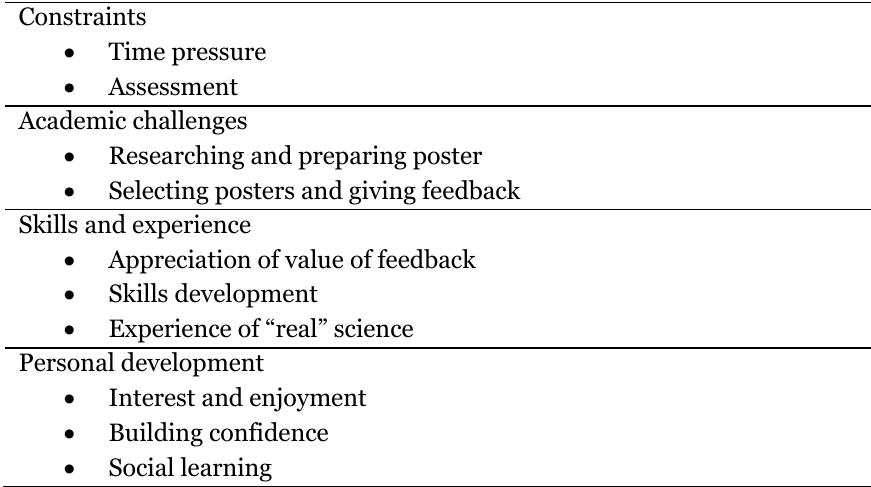
Themes and Subthemes Identified from Focus Group Discussions